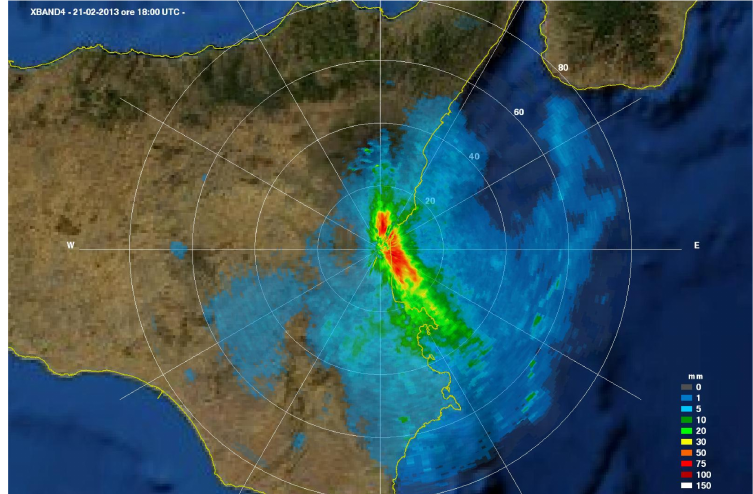
Figure 8. Map of cumulated precipitation as retrieved by the combined polarimetric algorithm between 15:00 and 18:00UTC on 21 Febru- ary